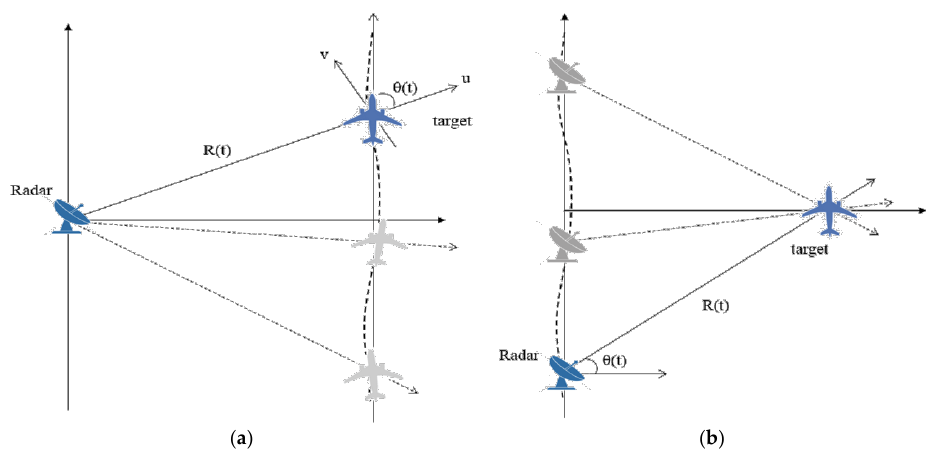
Figure 3. Comparison of ISAR and SAR imaging geometries: ( a ) ISAR case; ( b ) SAR case.